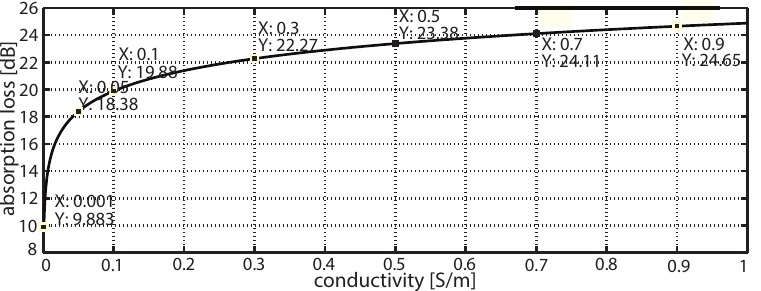
Figure 8. Absorption loss in 2.4 GHz in freshwater conductivity.